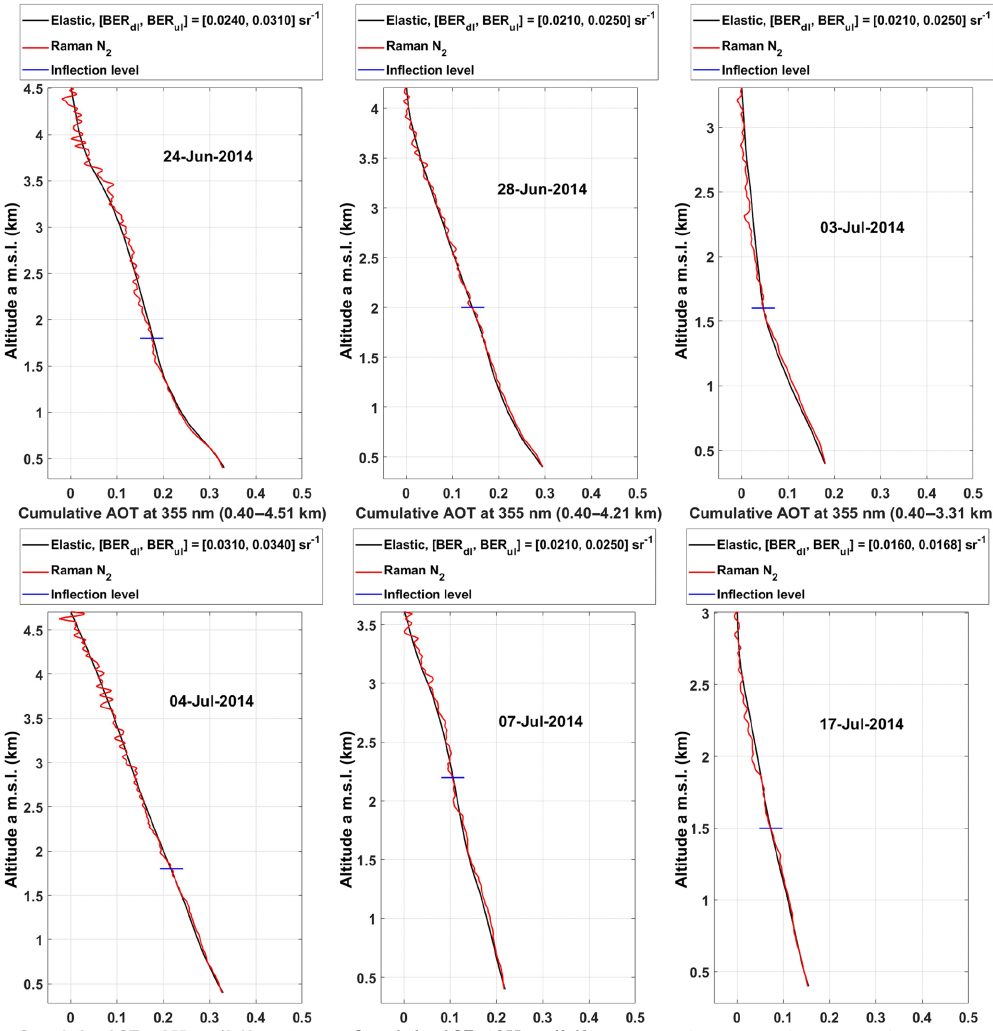
Figure 5. Vertical profiles of the cumulative aerosol optical thickness (AOT) for six different nights. The lidar profiles are time-averaged between 23:00UTC the previous day and 04:00UTC the next day. The inflection levels between the two main aerosol layers are highlighted by a horizontal blue line for each night. The backscatter-to-extinction ratios (BERs) are given in the legends in parentheses for the lower (BER dl ) and upper (BER ul ) aerosol